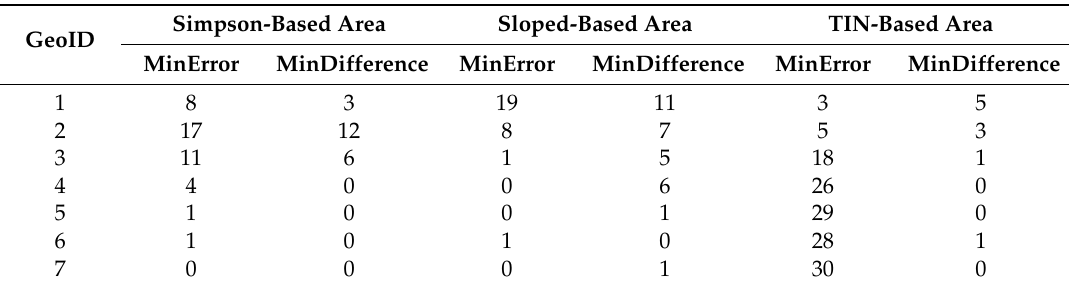
Table 1. Relative error number distribution.